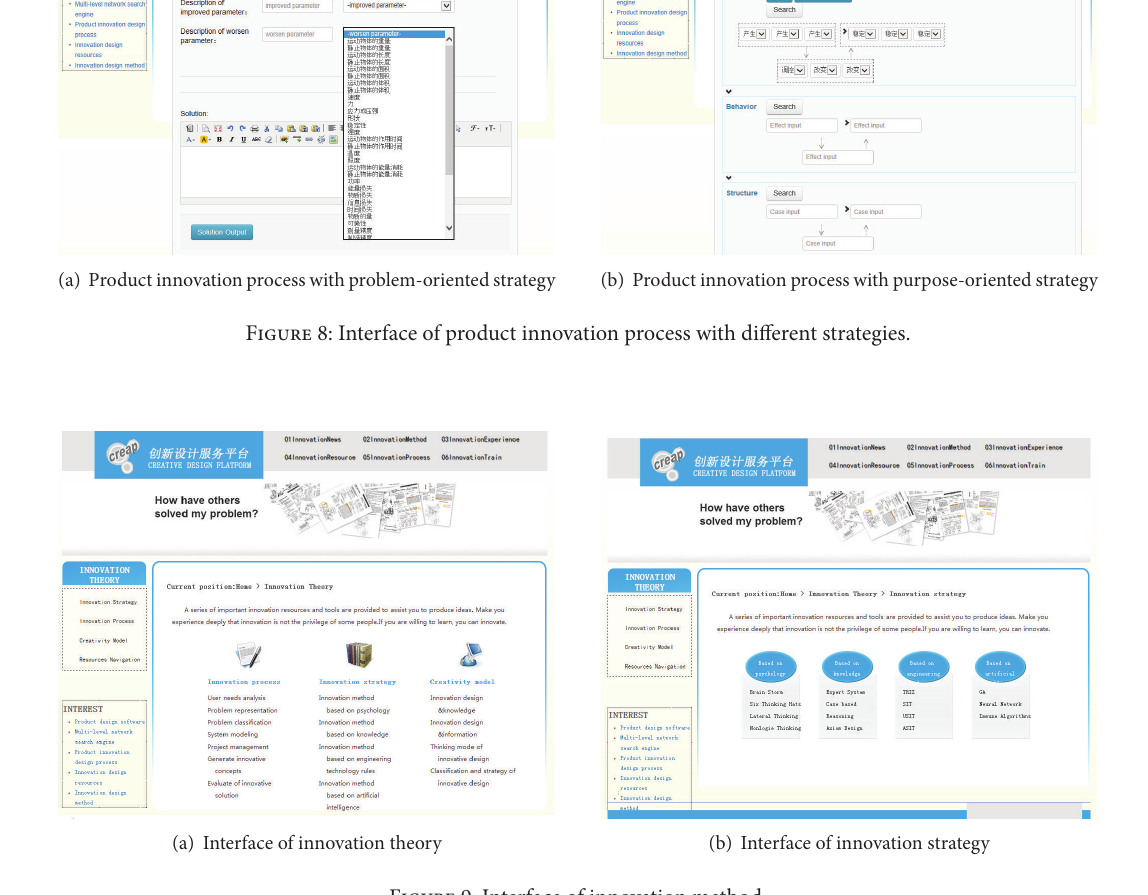
Figure 9: Interface of innovation method.